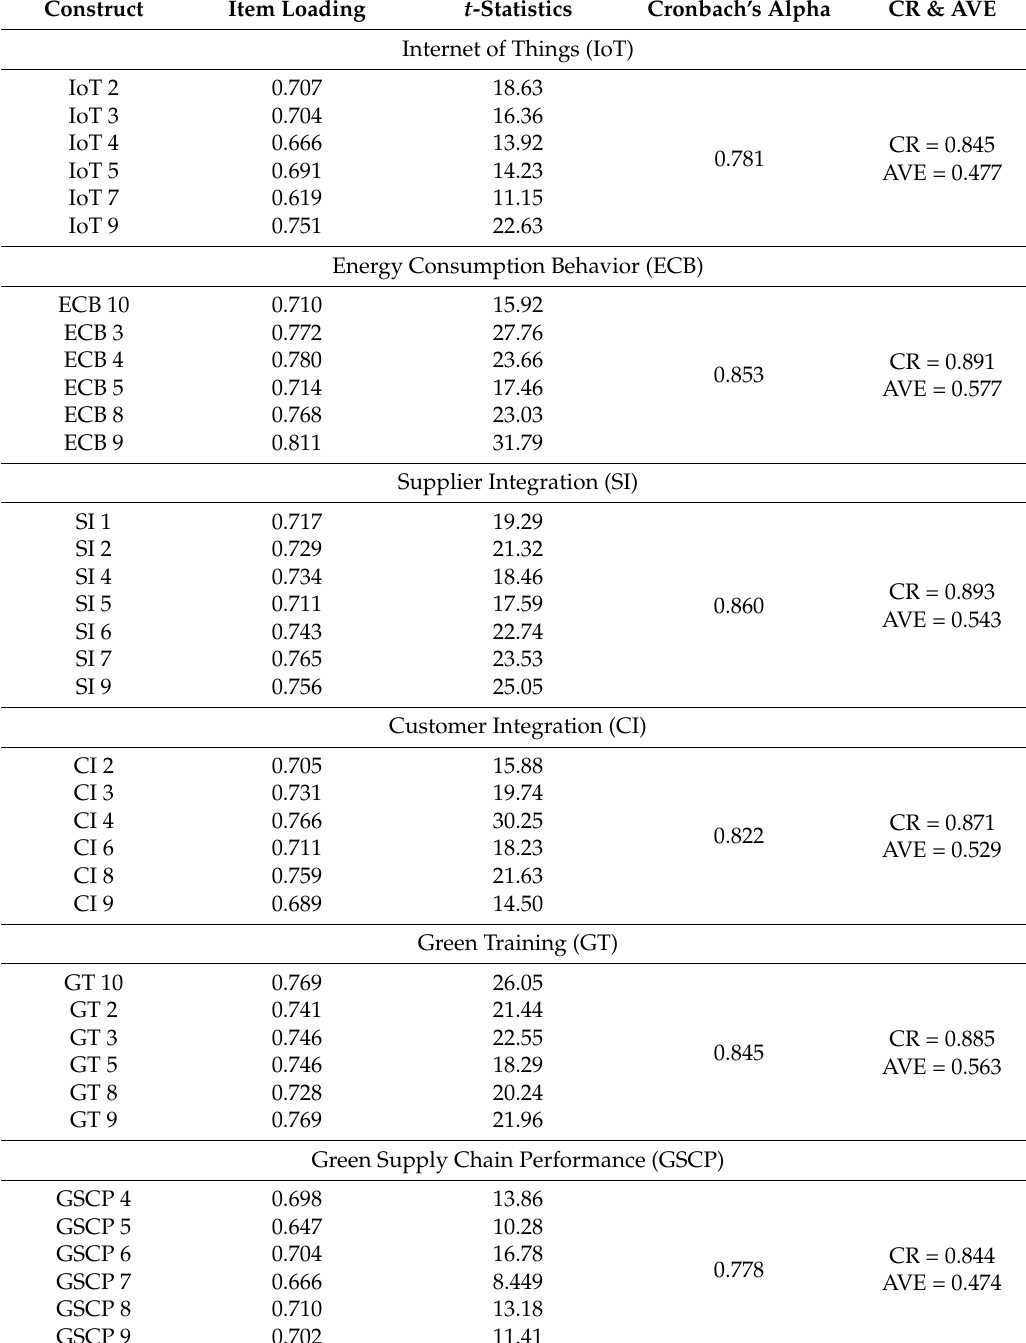
Table 3. Factor loadings, t -statistics, composite reliability (CR), and average variance extracted